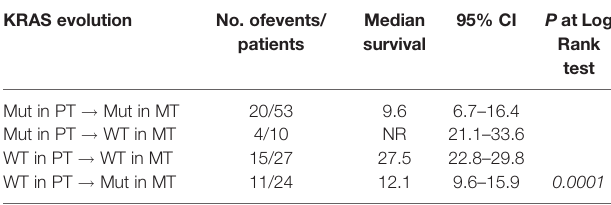
TABLE 4 | Univariate analysis of KRAS mutations ’ evolution prognostic power. KRAS